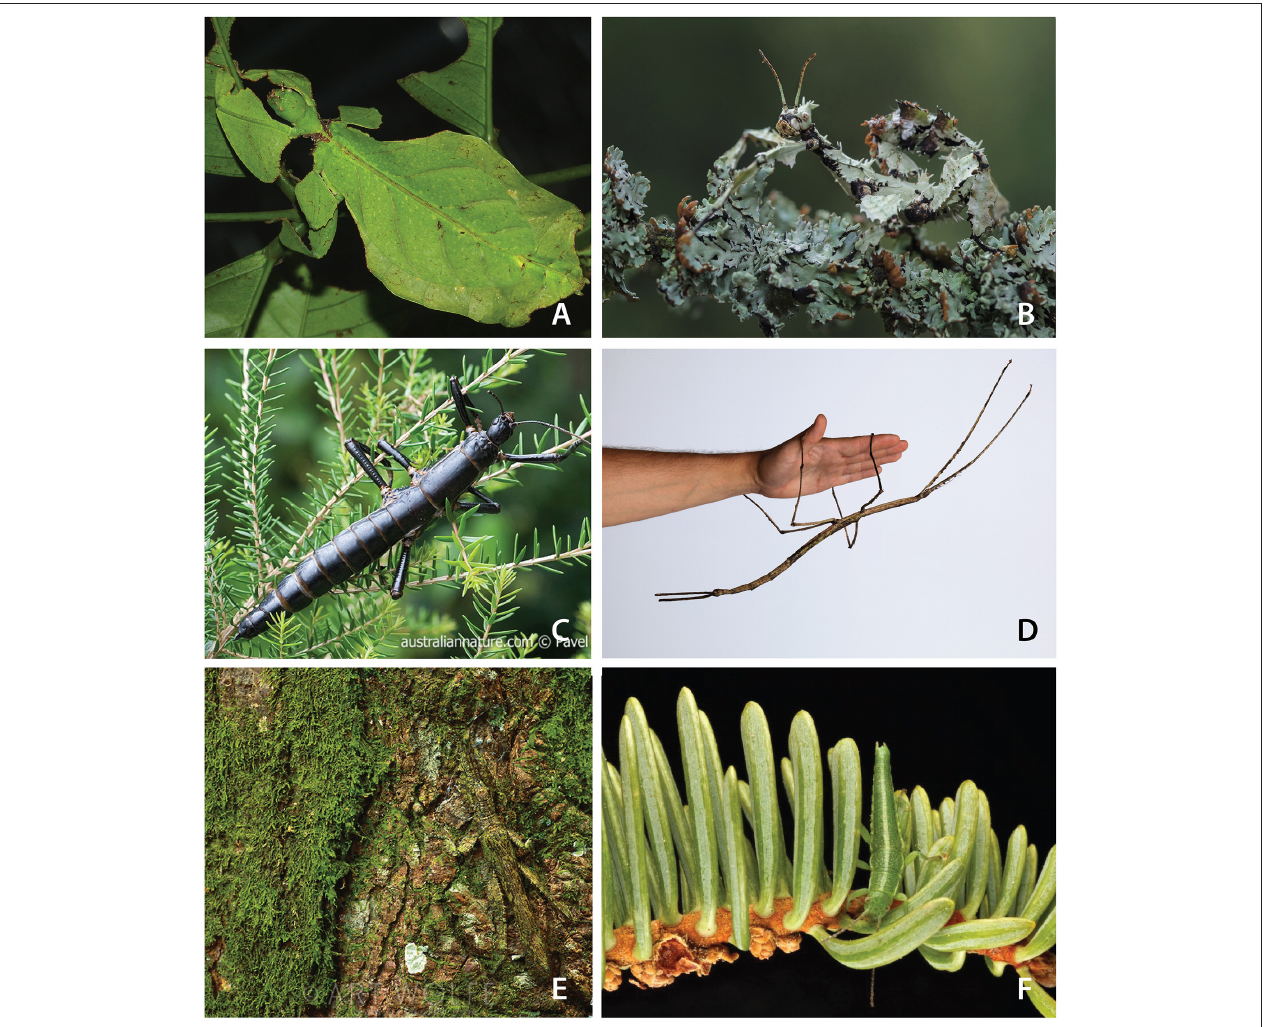
FIGURE 1 | A glimpse of stick and leaf insect diversity and masquerade crypsis. (A) A leaf insect, Phyllium (photograph by Bernard Dupont, used by permission). (B) Extatasoma tiaratum (photograph by Miroslaw Wasinski, used by permission). (C) The Lord Howe stick insect, Dryococelus australis , the rarest known insect on the planet (photograph by Pavel German, used by permission). (D) Ctenomorpha gargantuan , measuring 56.5cm in length (photograph by the Museum of Victoria, used by permission). (E) Prisopus sp. (photograph by Art Wolfe, used by permission). (F) Timema cristinae (photograph by Moritz Muschick, used by